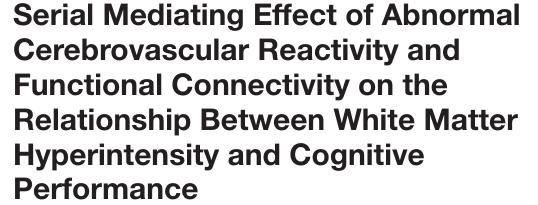
TABLE 3 | Brain areas that displayed different functional connectivity values among the three groups. Brain